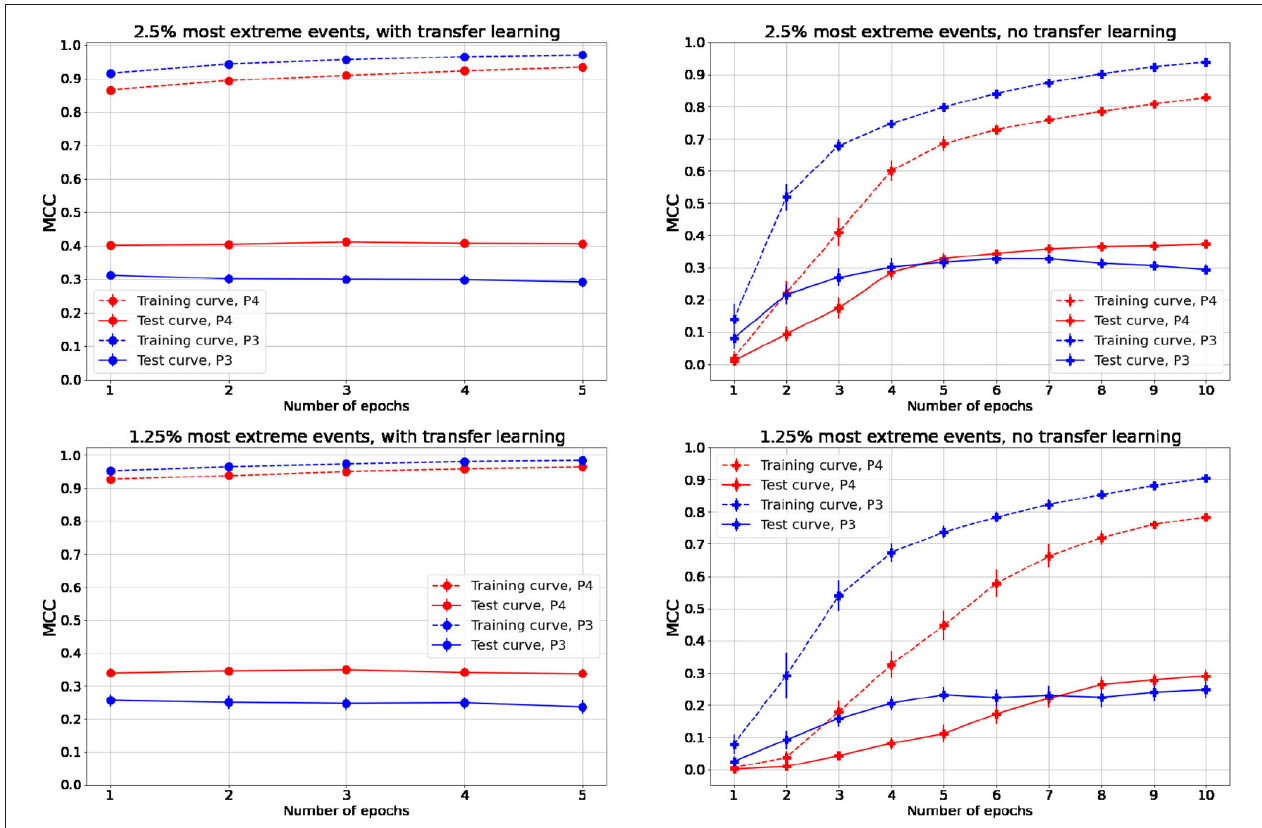
FIGURE 3 | Forecasting performance in terms of MCC as a function of the number of epochs, for aggregation protocols P3 (Combined- T s Z g ) (blue) and P4 (Stacked- T s Z g ) (red), without (“+,” plots on the right) and with (“o,” plots on the left) transfer learning. Solid (resp., dashed) lines correspond to testing (resp. training) performance. Top and bottom plots correspond, respectively to the 2.5 and 1.25 % most extreme events. Average MCC are obtained from 40 independent learning. Note that the discrepancy of values of MCC between training and test sets is due to the difference in class imbalance: training (solid lines) set is undersampled and the reduction in class imbalance (here: only 2) leads to a large MCC, while test set (dashed lines) has a high class imbalance ratio by definition of the problem of predicting extreme events and cannot achieve the same